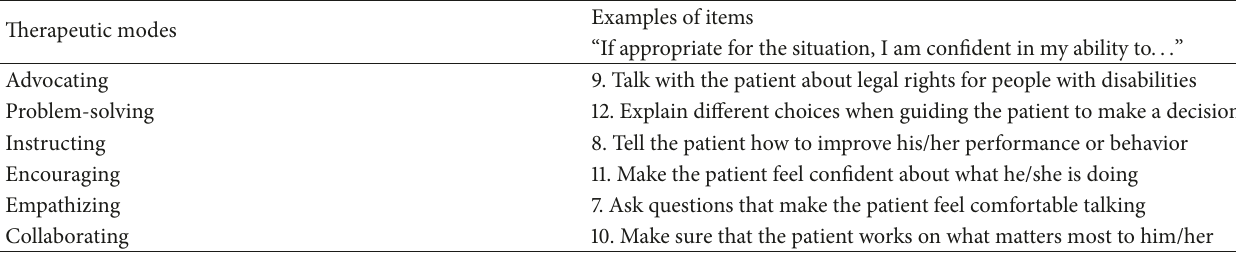
Table 1: Examples of items related to each of the six therapeutic modes assessed with the Norwegian client assessment of modes, adapted for the purpose of this